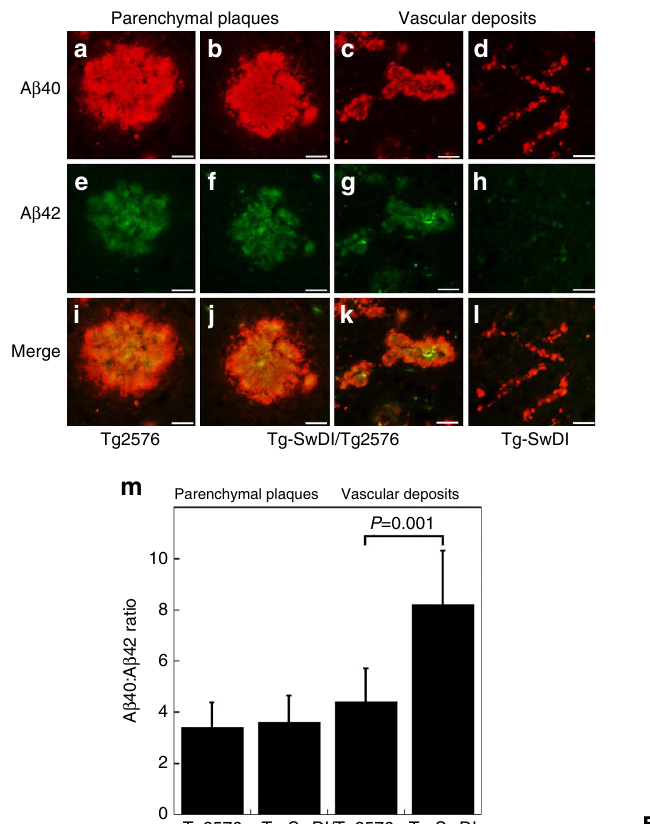
Figure 6 | Quantitative immunohistochemical analysis of cerebral human wild-type A b deposition in the different transgenic mice. Brain sections obtained from the different transgenic mouse lines at eighteen months of age were double immunolabelled for human A b using a polyclonal anti-A b (pAb-A b ) antibody which recognizes both wild-type and CAA mutant A b , (green) ( a – d ) and mAb4G8, which recognizes wild-type A b , but not CAA mutant A b , (red) ( e – h ) and images were merged ( i – l ). Scale bars, 50 m m. ( m ) The levels of pAb-A b -positive total A b (green) and mAb4G8-positive wild-type A b (red) in parenchymal plaque and capillary deposits were determined in the different transgenic lines. The data presented are the mean ± s.d. of 15 deposits per each line of